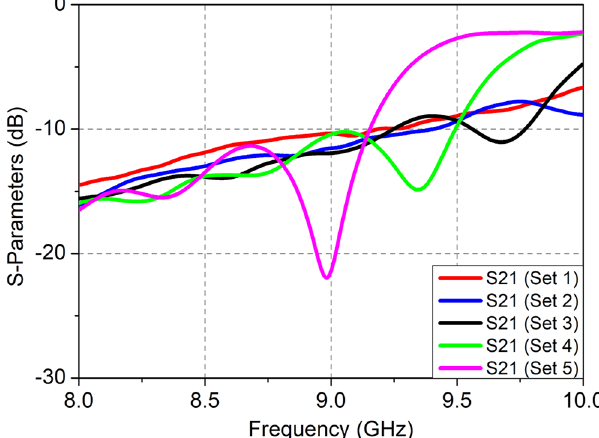
Fig. 10. Simulated result of the S21 of the designed antenna according to the set